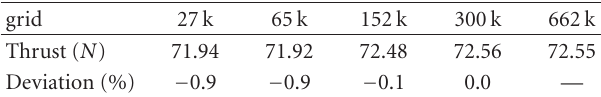
Table 2: Deviation of blade thrust to value of finest grid for the RANS grid study ( J = 0 .